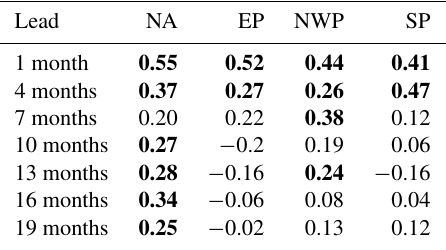
Table 3. Correlation coefficients of normalized seasonal-mean (JJASON for the Northern Hemisphere; DJFMAM for the Southern Hemisphere) TC ACE between the observations and the SMYLE hindcasts (rows give lead time). Bold numbers indicate that corre- lations are significant at the 90% confidence level ( p < 0.1). The correlations in the north and south Indian Ocean are not significant at any lead time and are therefore not shown. Note that at 19-month lead time (bottom row), data from SMYLE-NOV are for JJASO (in- stead of JJASON) given the 24-month simulation length. Similarly, data from SMYLE-MAY at 19-month lead are for DJFMA (instead of